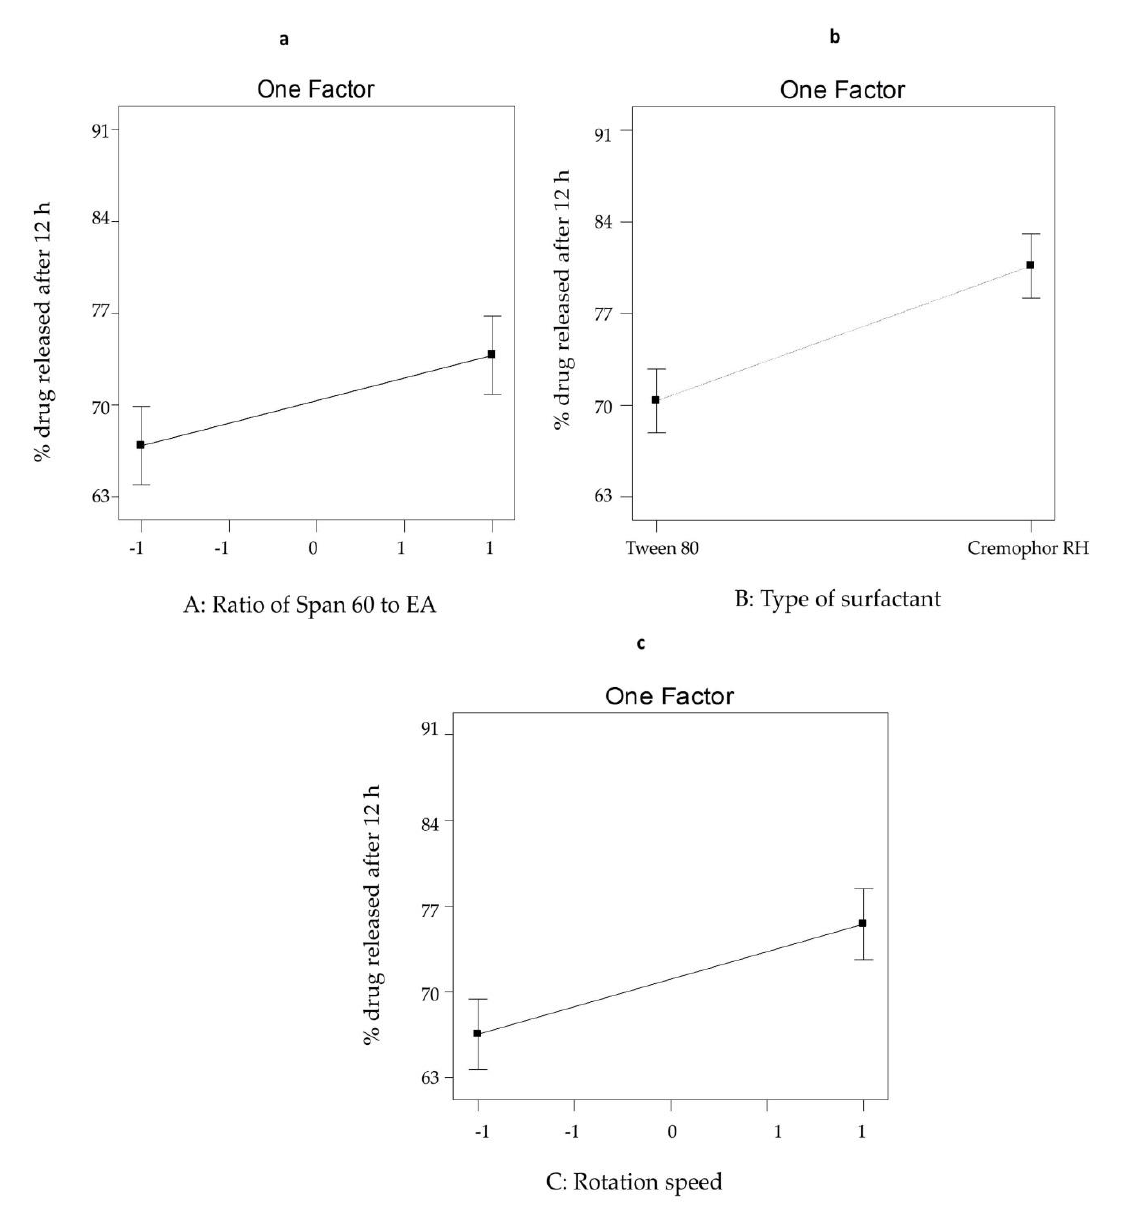
Figure 3. The influence of different independent variables ( a ) ratio of Span 60 to EA, ( b ) type of surfactant and ( c ) rotation speed on Q 12h of SV-loaded nanospanlastics according to 2 3 factorial design. Abbreviations: SV, Sodium valproate; Q 12h , % drug released after 12 h.